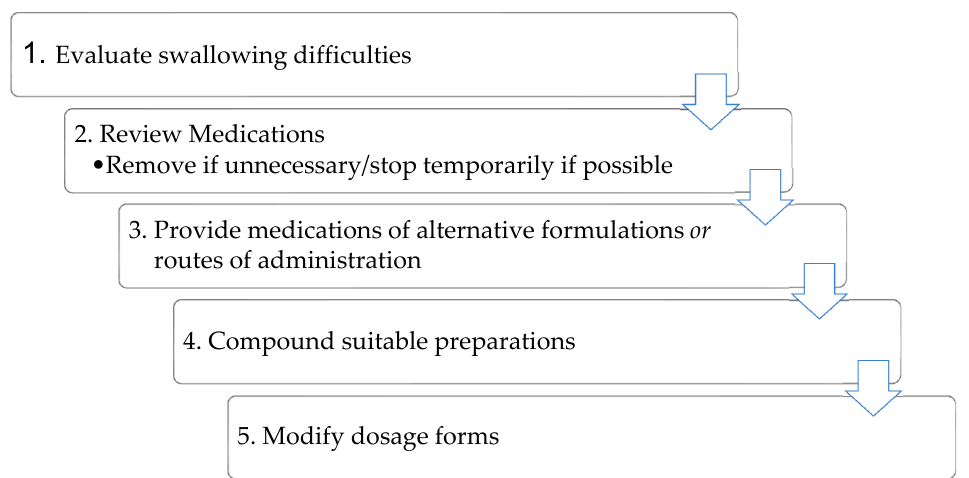
Figure 1. Medication dysphagia management plan summarizing common recommendations. DFM includes, but is not limited to, cu tt ing, crushing, or chewing tablets, opening capsules, and mixing SODF contents with fl uids for swallowing or administration via en- teral tubes; it excludes instances where DFM is by design, such as chewable or e ff ervescent tablets. DFM may alter a medication’s pharmacokinetic pro fi le and e ffi cacy, increase the